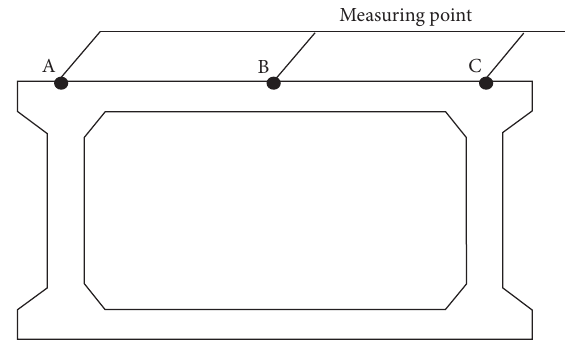
Figure 24: Layout drawing of arch ring elevation measuring point.